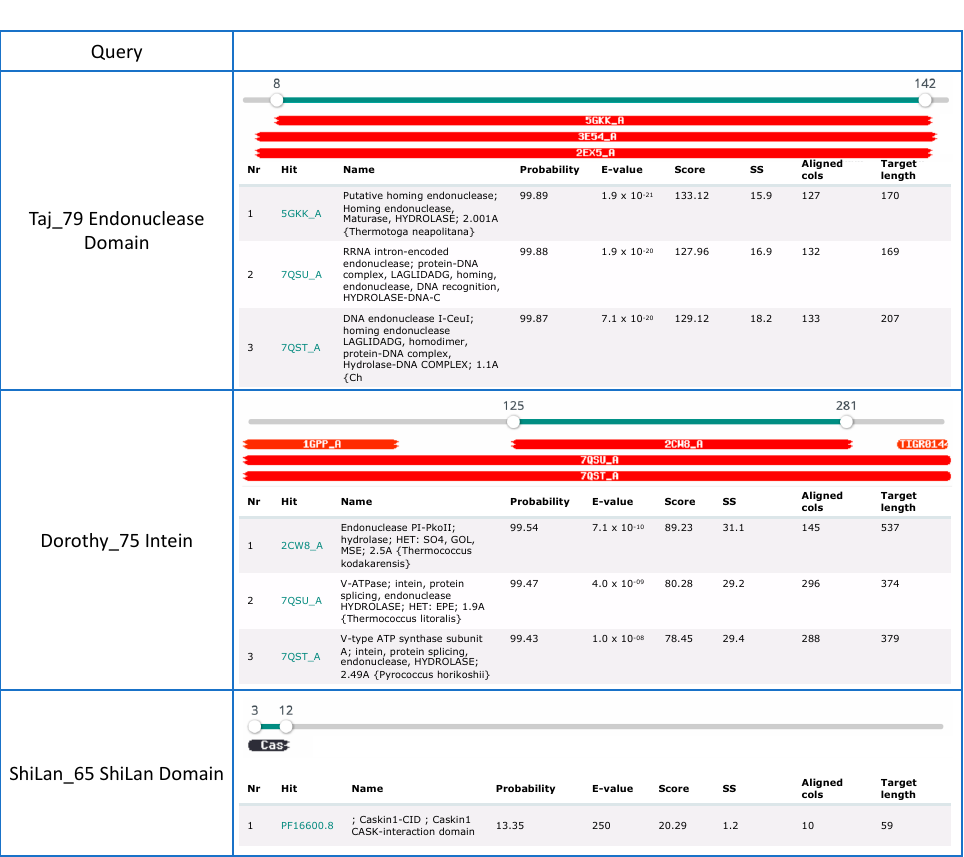
Figure 2. Alignment of the beginning and end of the intein (panel A ) and the ShiLan domain (panel B ) with their associated surrounding regions. In the Dorothy phage, the intein is 327 amino acids long. In the ShiLan phage, the ShiLan domain is 202 amino acids long.